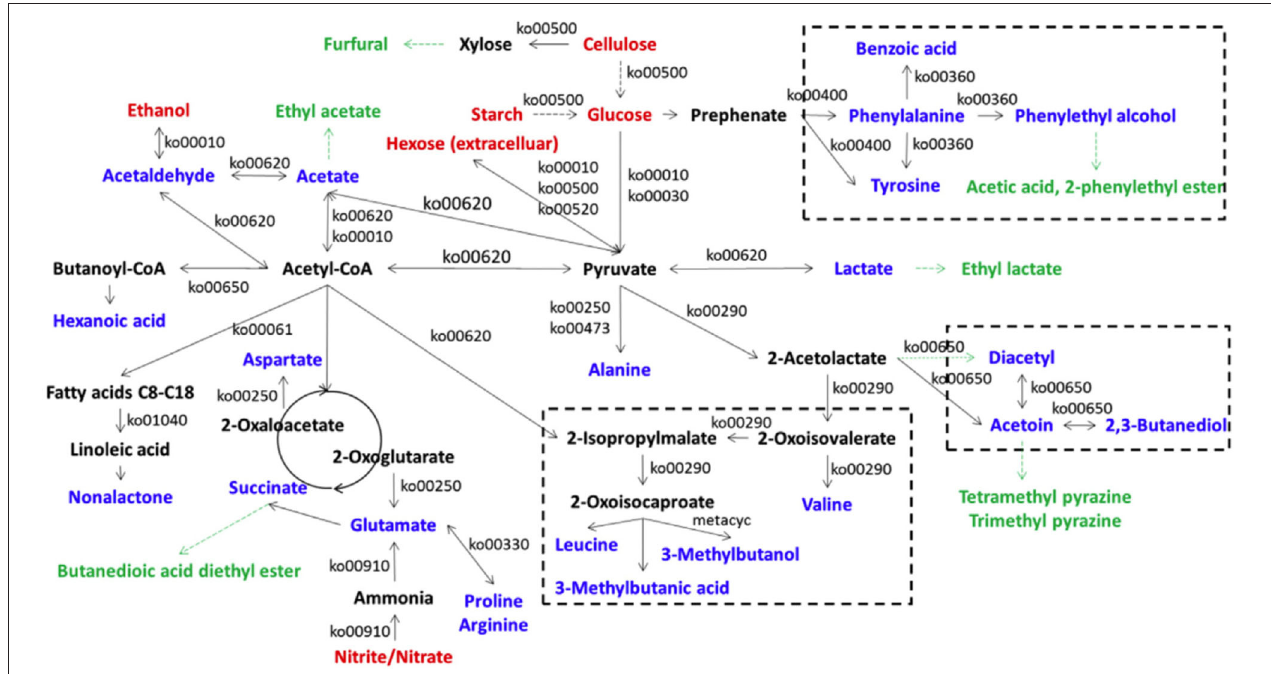
FIGURE 5 | The metabolic network for substrate breakdown and formation of VOCs and amino acids via the microbial community in traditional Zhenjiang aged vinegar (Cited and modified from Wu et al., 2017). Red fonts represent the main substrates from the raw materials; deep black fonts represent amino acids or the intermediate compounds relative to the formation of VVOCs; black fonts represent the enzymes in the relative pathways predicted by the Kyoto Encyclopedia of Genes and Genomes; green fonts represent non-enzyme producing VVOCs.